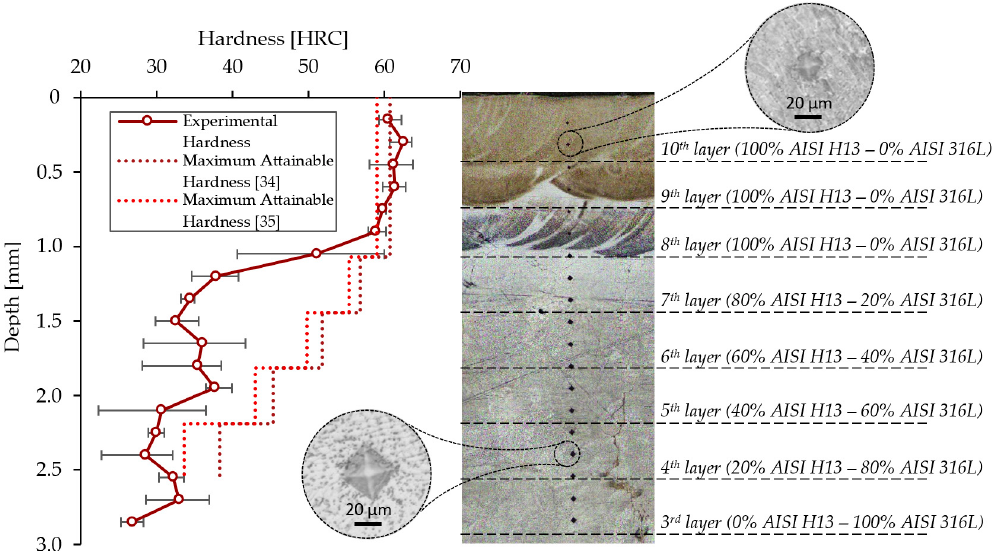
Figure 9. Hardness of the AISI 316L to AISI H13 FGM sample, with respect to the maximum attainable hardness achieved by steels based on the carbon content.